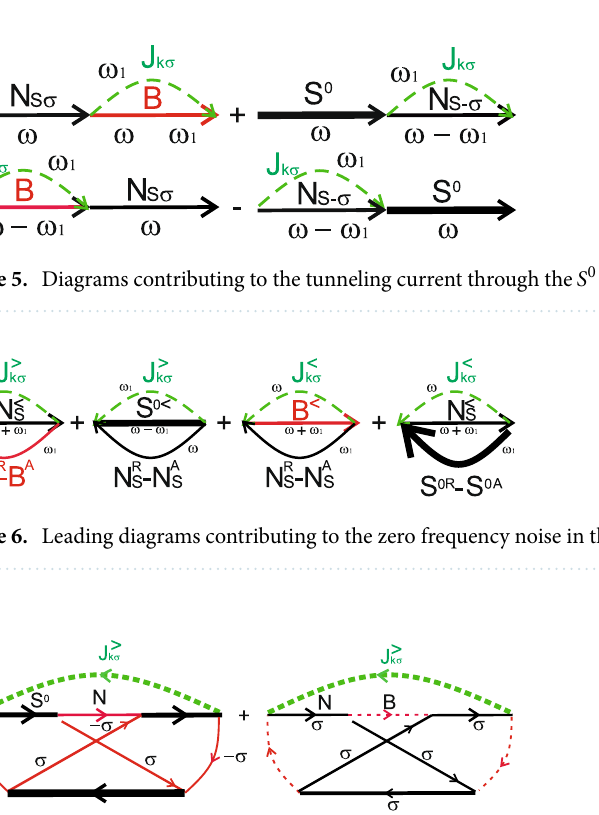
Figure 7. Maximally crossing diagrams contributing to the zero frequency noise quantum corrections in the 0 S 0 S − −